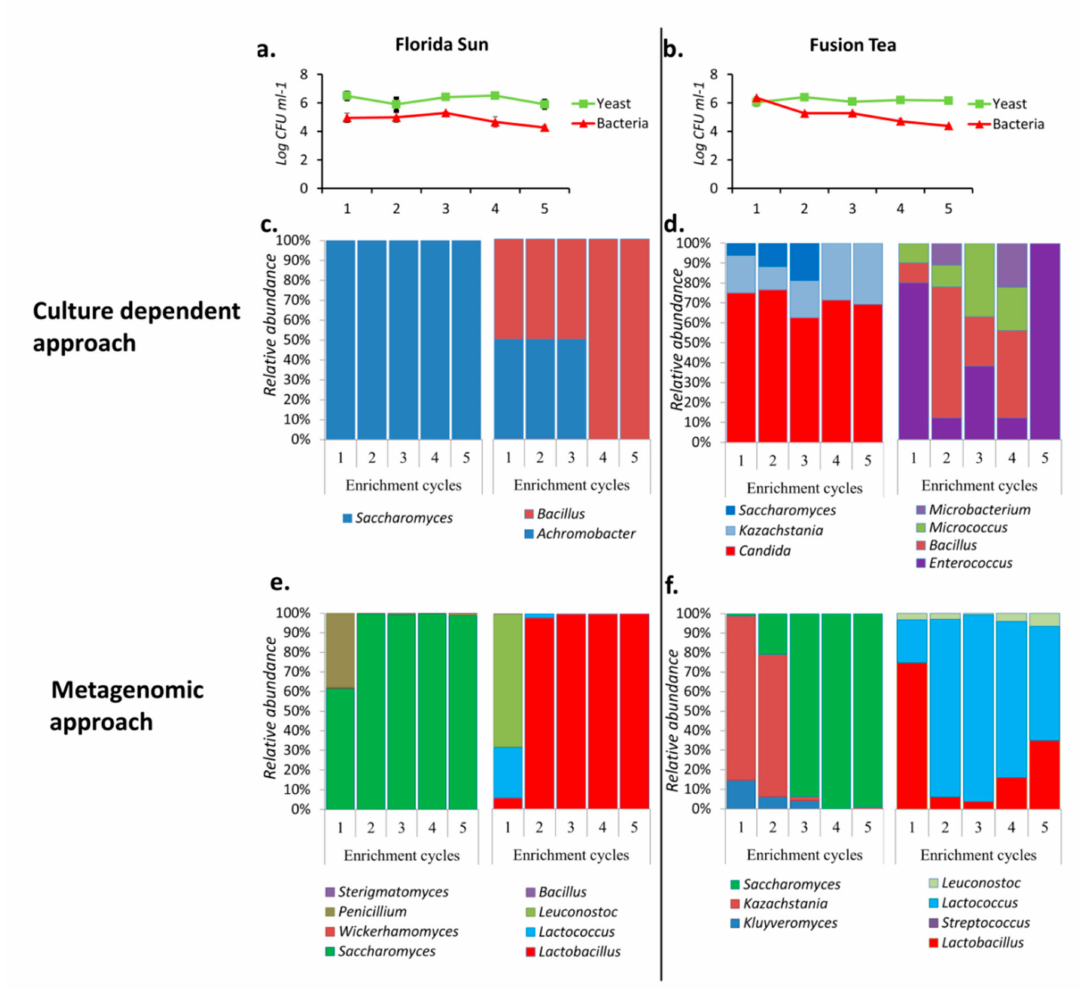
Figure 4. Population dynamics (CFUs) of yeasts and bacteria in Florida Sun ( a ) and Fusion Tea ( b ) and relative abundances and dynamics of the dominant yeast and bacterial taxa during five successive enrichment cycles of growth of kefir grains obtained by culture dependent ( c —Florida Sun; d —Fusion Tea) and metagenomics approach ( e —Florida Sun; f —Fusion